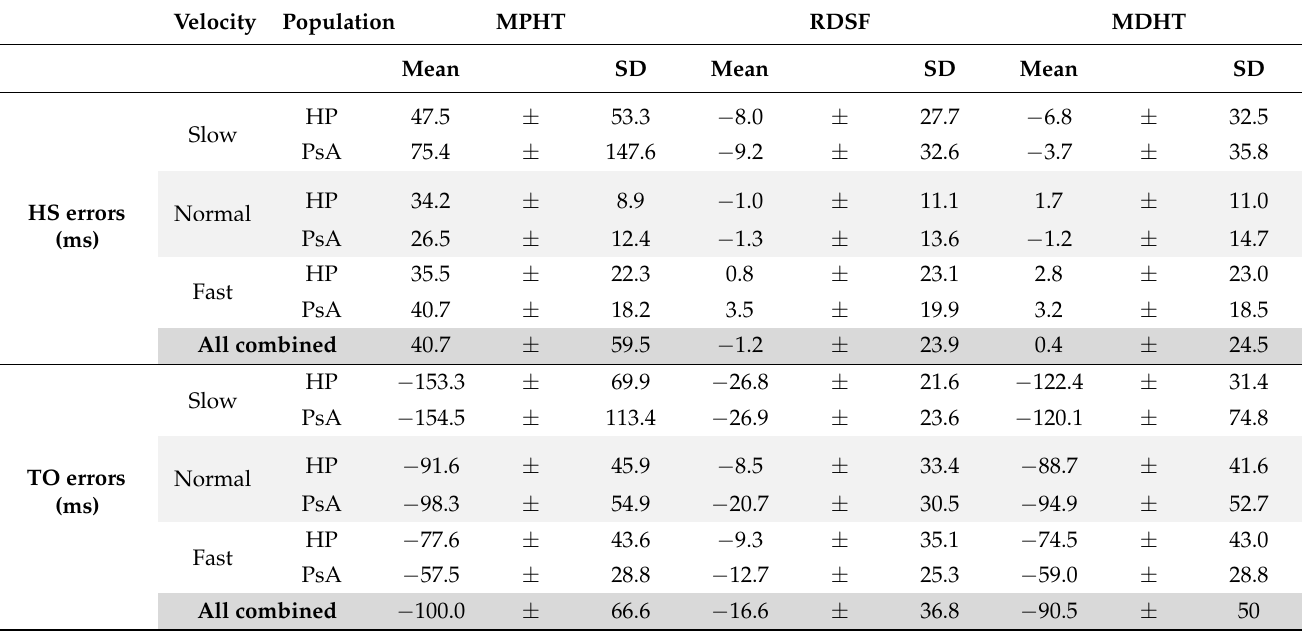
Table 1. Gait events accuracy compared to force plates for slow, normal, and fast walking